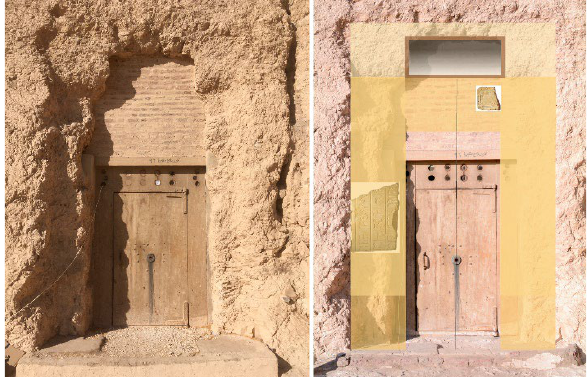
Figure 3 . TT96’s front door in 2019 (left) and hypothesis about the presence of a hypaethral opening (right)